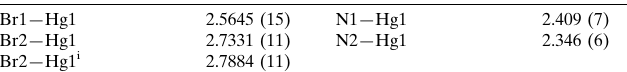
Selected bond lengths (A˚